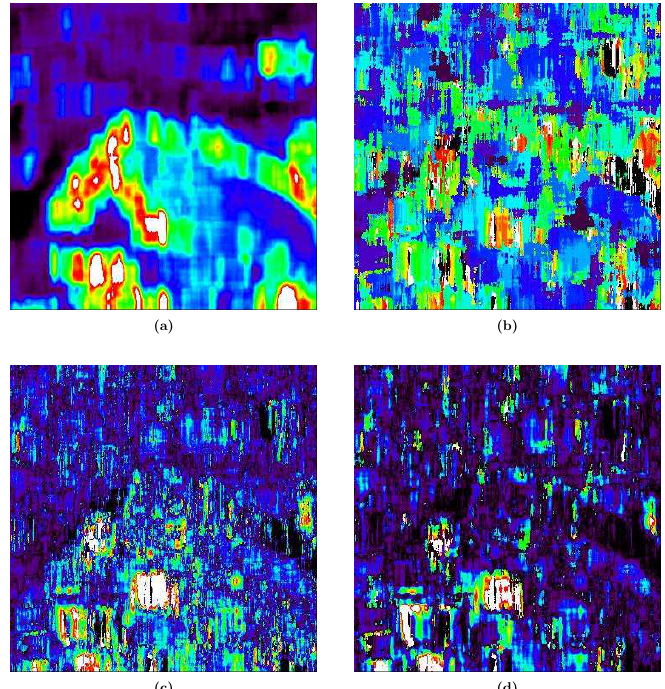
Figure 7. Vario-parameter maps resultant from classification of RADARSAT data set in Figure 3a. Based on first-order directional vario functions in 0 ◦ (east–west) direction calculated for windows of 40 by 40 pixels with offset 1 pixel. ( a ) pond; ( b ) mindist; ( c ) p1; ( d )